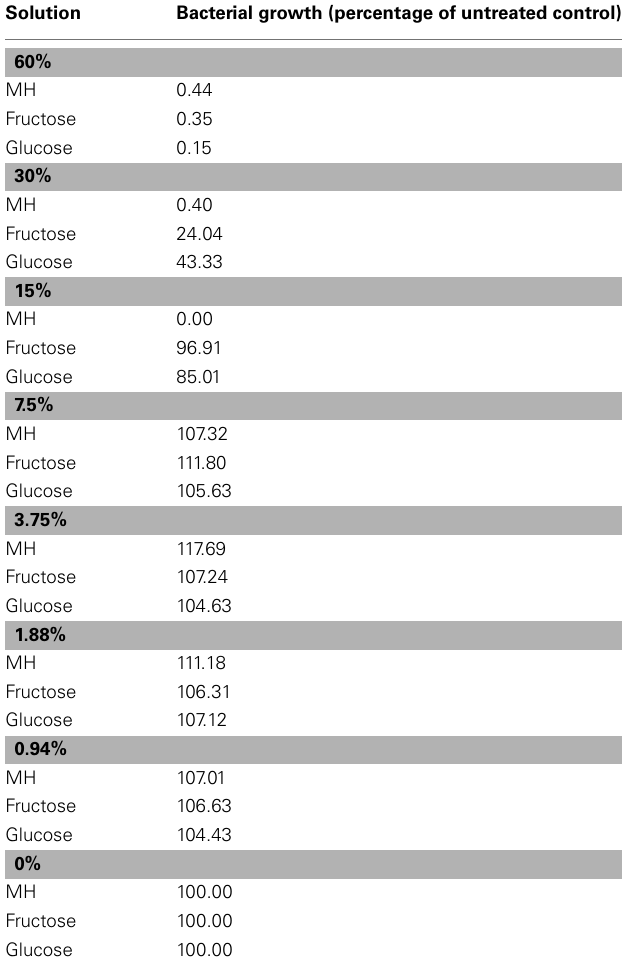
Table 1 | Manuka honey has a higher MIC than equivalent sugar